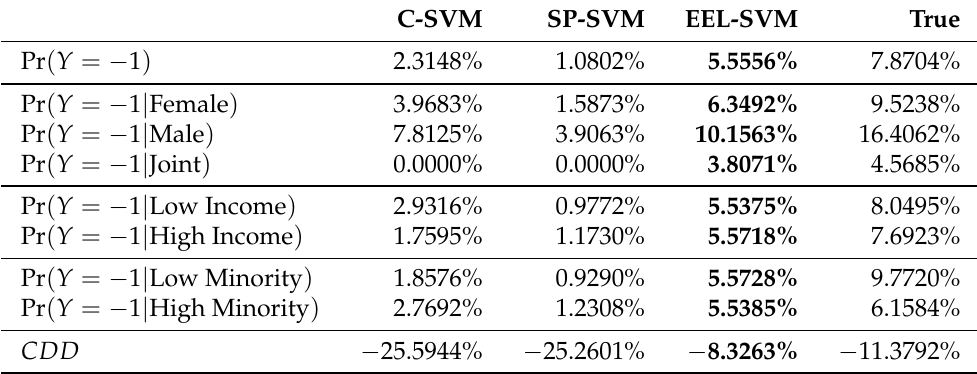
Table 9. Probability of denied loan for the three classification methods. Closest value (per row) to ‘true’ probability in